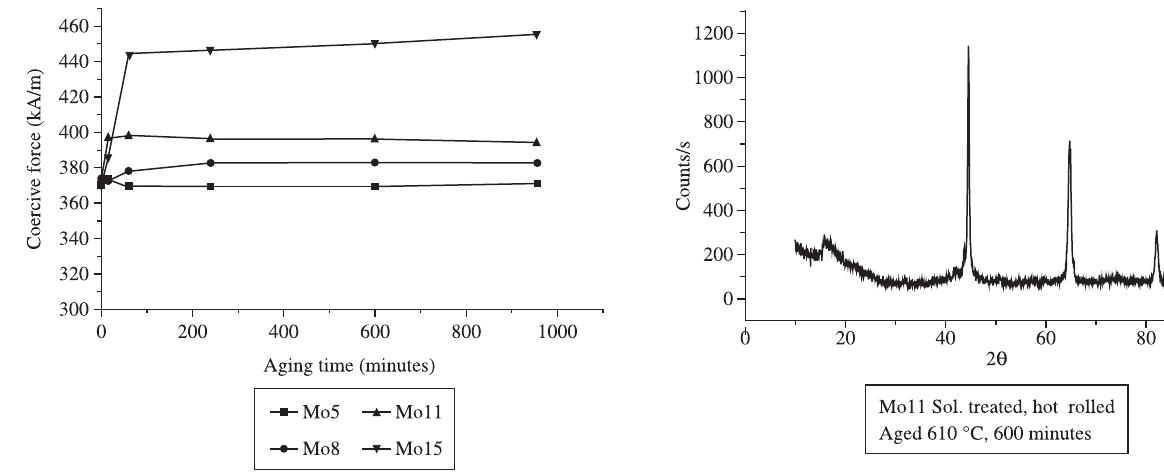
Figure 3. Coercive force vs. magnetic aging of Fe-Mo-Ni-C alloys, for dif- ferent molybdenum concentrations.